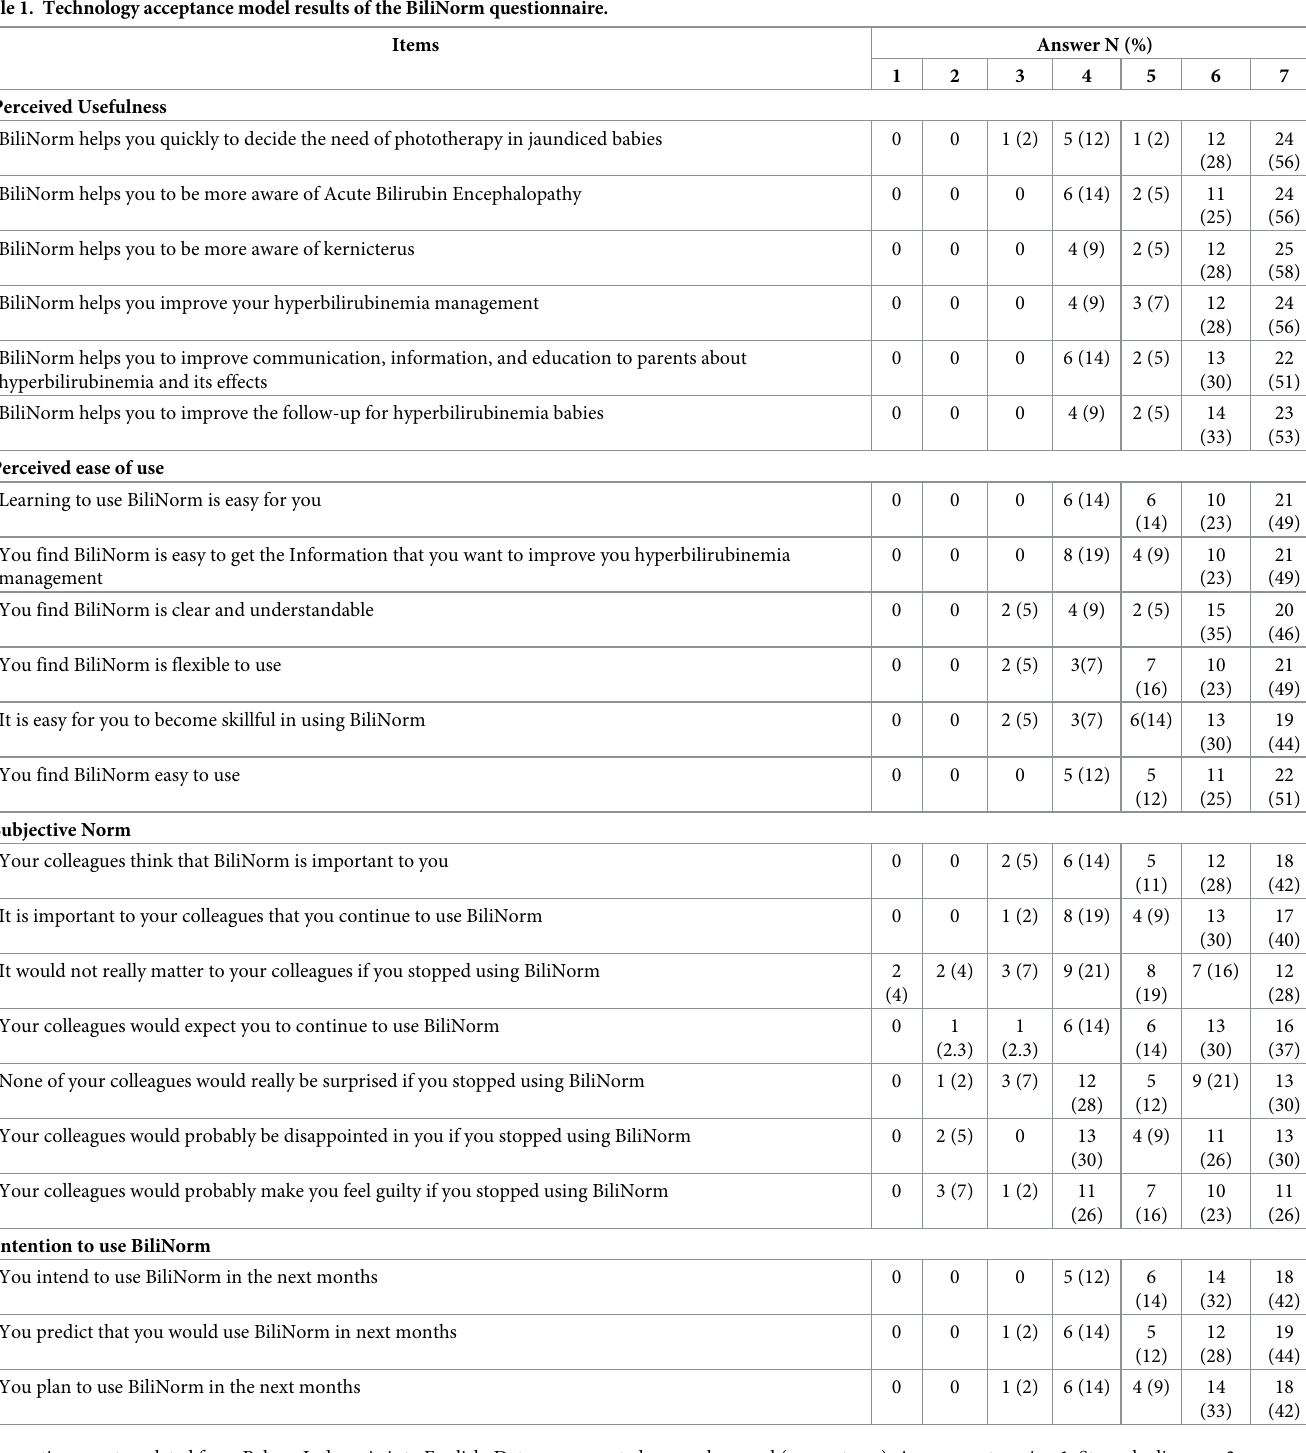
Table 1. Technology acceptance model results of the BiliNorm questionnaire. Items Answer N